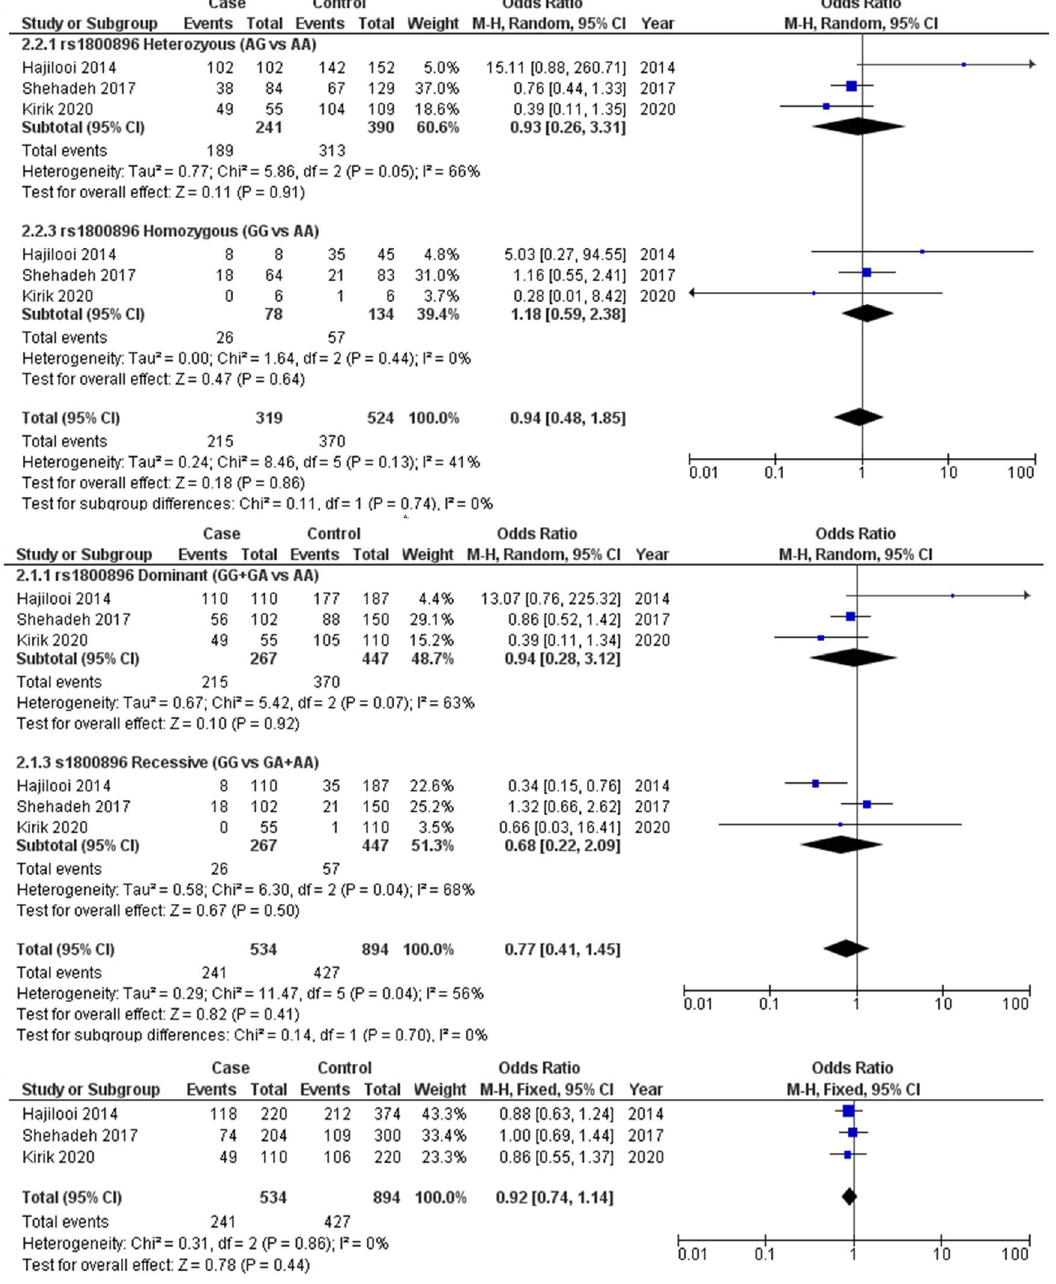
and recessive models. ( c ) Allelic